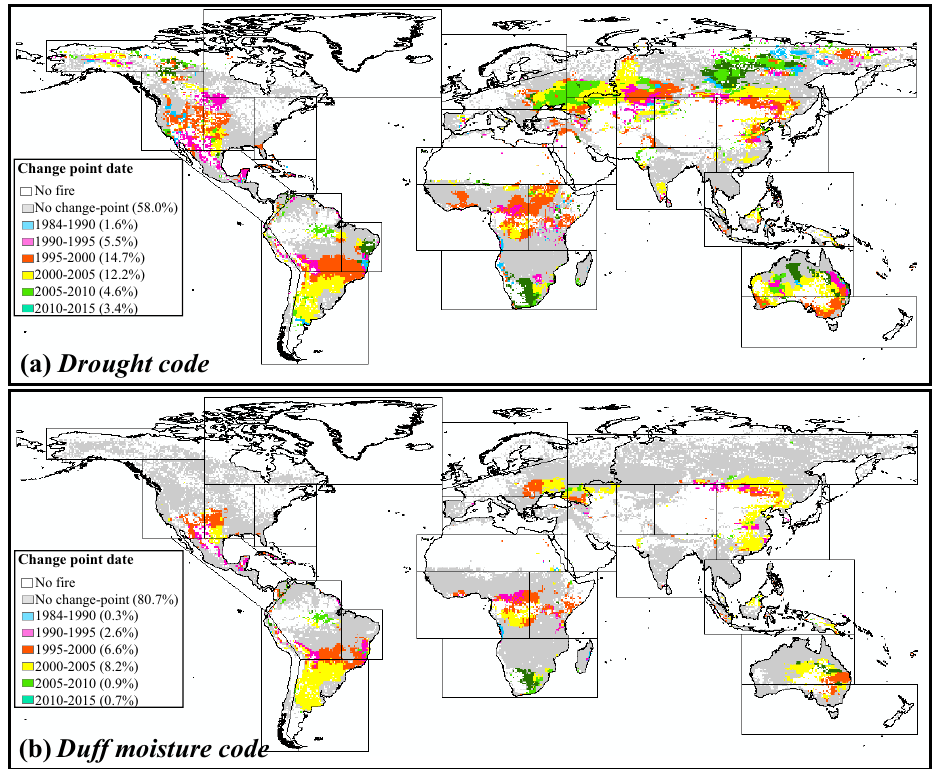
Fig. 4 Global map-2 showing the distributions of the change-points. This global map-2 shows the distributions of the change-points of the drought code and duffmoisture code on a monthly scale. The map is marked with grids of significant change-points,where different colors indicate when an abrupt change occurs. Blanks in the figure indicate areaswithout wildfires. Numbers in parentheses indicate the percentage of change-point